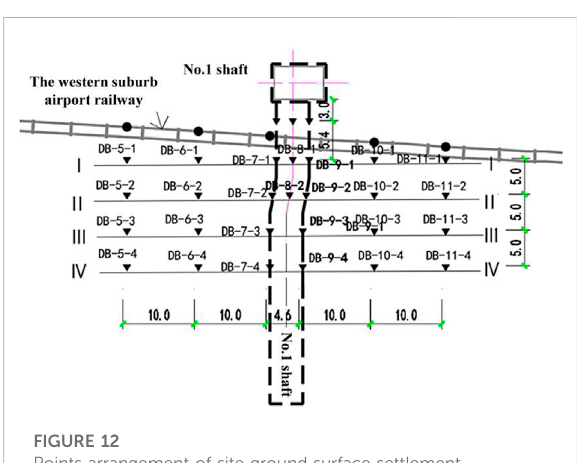
FIGURE 12 Points arrangement of site ground surface settlement monitoring for 1# shaft and